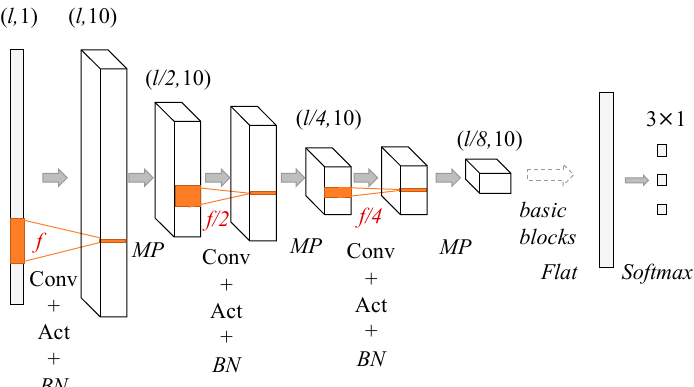
Figure 4. Convolutional neural network (CNN) structures used in building the qua_model and the pos_model. The dimensions of the input data decreased by 50% after each max pooling (MP) layer and the numbers of Conv layer are from 3 to 8.